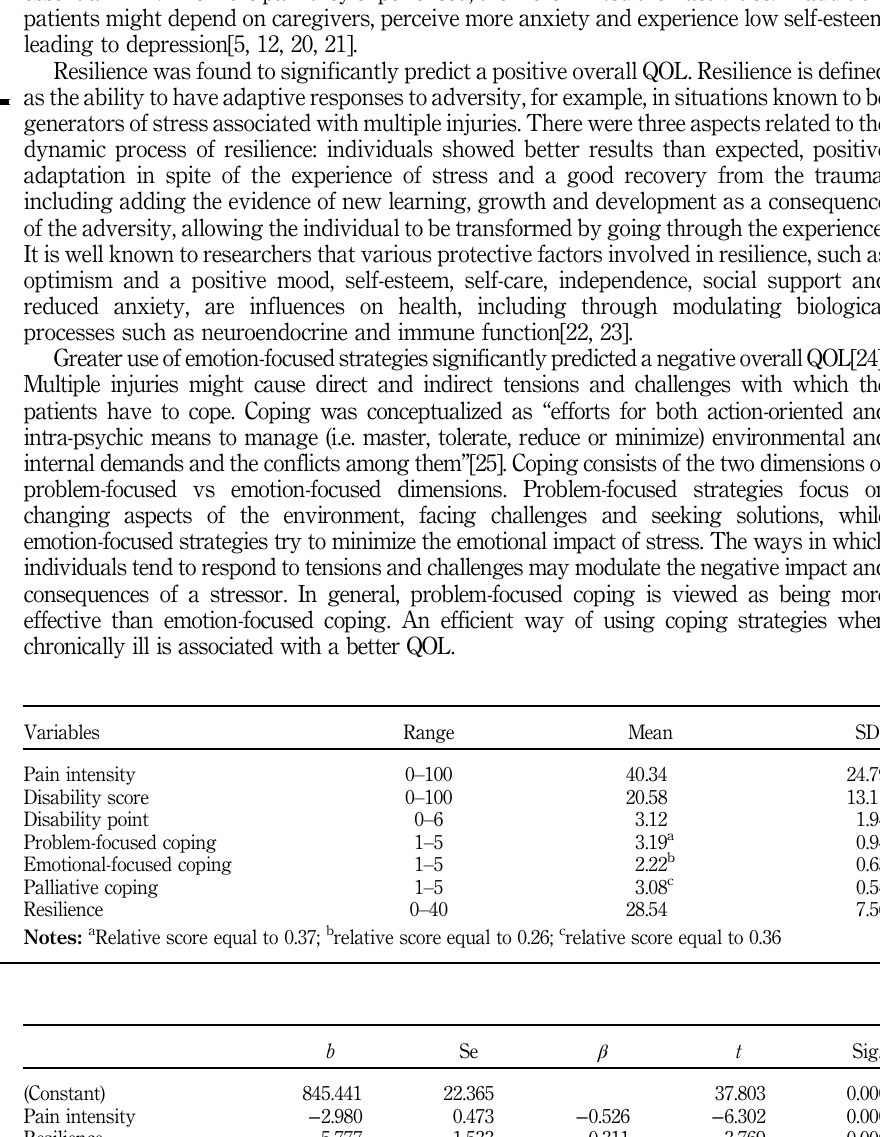
Table V. Regression analysis of predictors for the